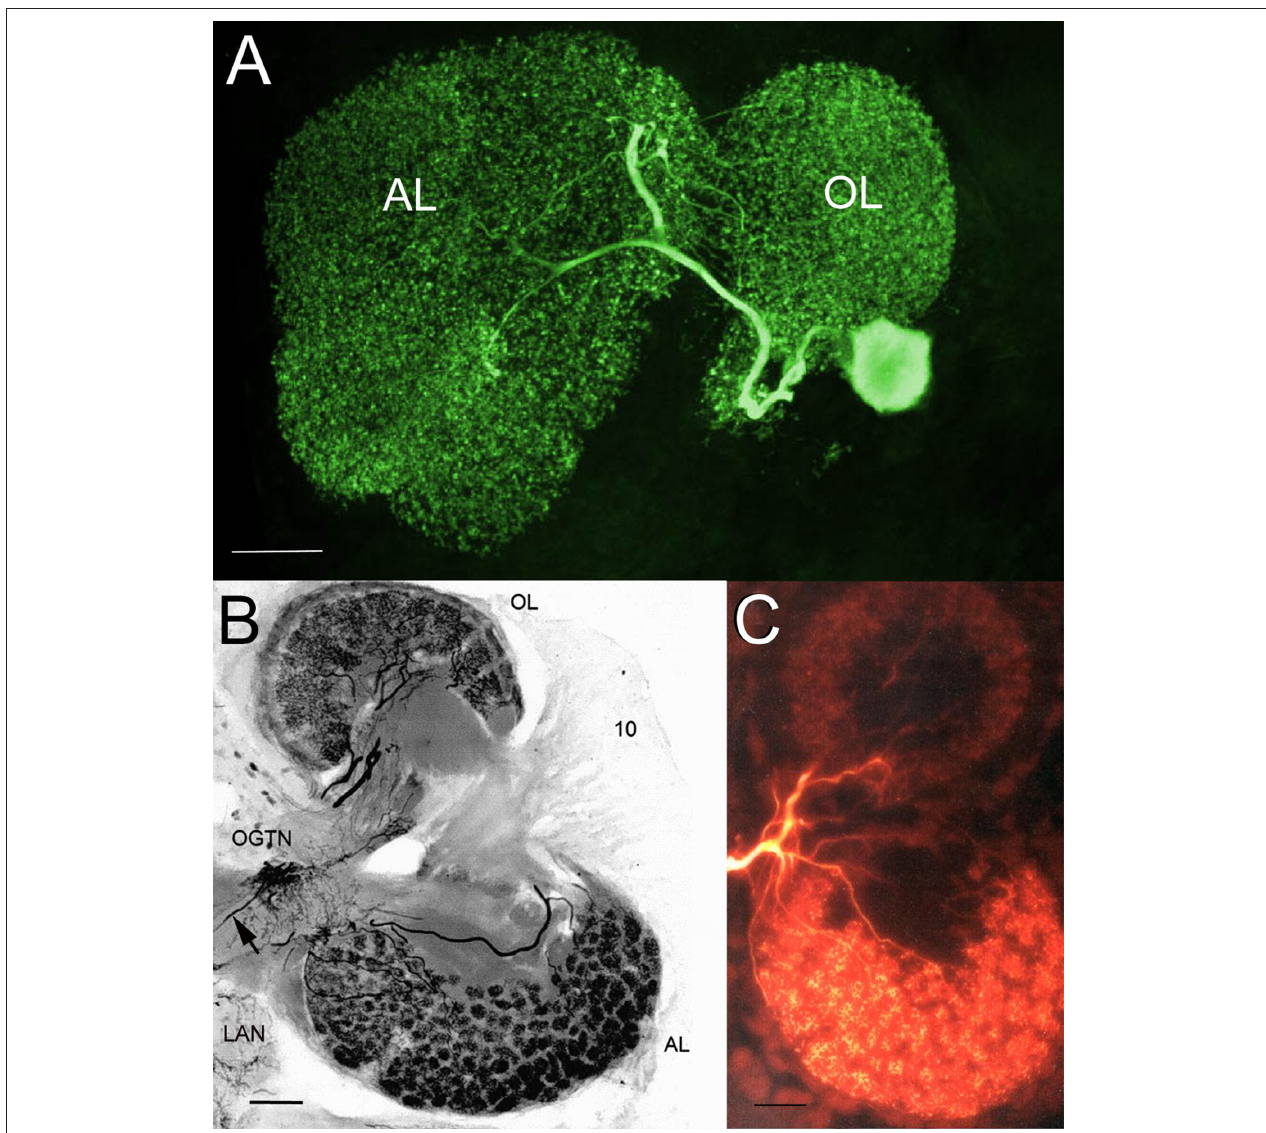
FIGURE 7 | The serotonergic dorsal giant neuron (DGN) innervates each and every glomerulus in the olfactory and accessory lobes. (A) Stacked confocal image of a neurobiotin-filled DGN in a lobster ( Homarus americanus ) embryo, revealing the massive projections of the DGN within the olfactory and accessory lobes. (B) Photomicrograph of a thick section (100 µ m) of the right side of the adult brain of the Australian crayfish Cherax destructor immunolabeled for serotonin. The DGN is the only serotonergic neuron that projects to the AL, but shares its projection into the OL with at least two other serotonergic midbrain neurons. The large cell body of the DGN is dorsal and out of the section plane, but the thin primary neurite that connects it with the olfactory globular tract neuropil (OGTN) before it projects into the OL and AL is observed (arrow). 10, Cluster 10 cell bodies; LAN, lateral antennular neuropil. (C) Neurobiotin injection of the DGN in an adult C. destructor brain illustrating the projections of this neuron to virtually all glomeruli in the OL and AL. Scale bars: (A) , 50 µ m; (B,C) , 100 µ m. Adapted from Beltz and Sandeman (2003).